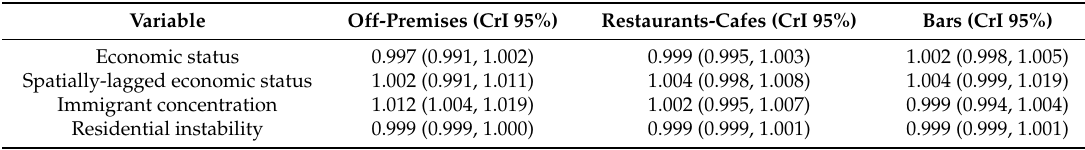
Table 5 indicates the odds ratios for covariates of the alcohol outlet models. Table 5. Odds ratios for variables of the alcohol outlet models.